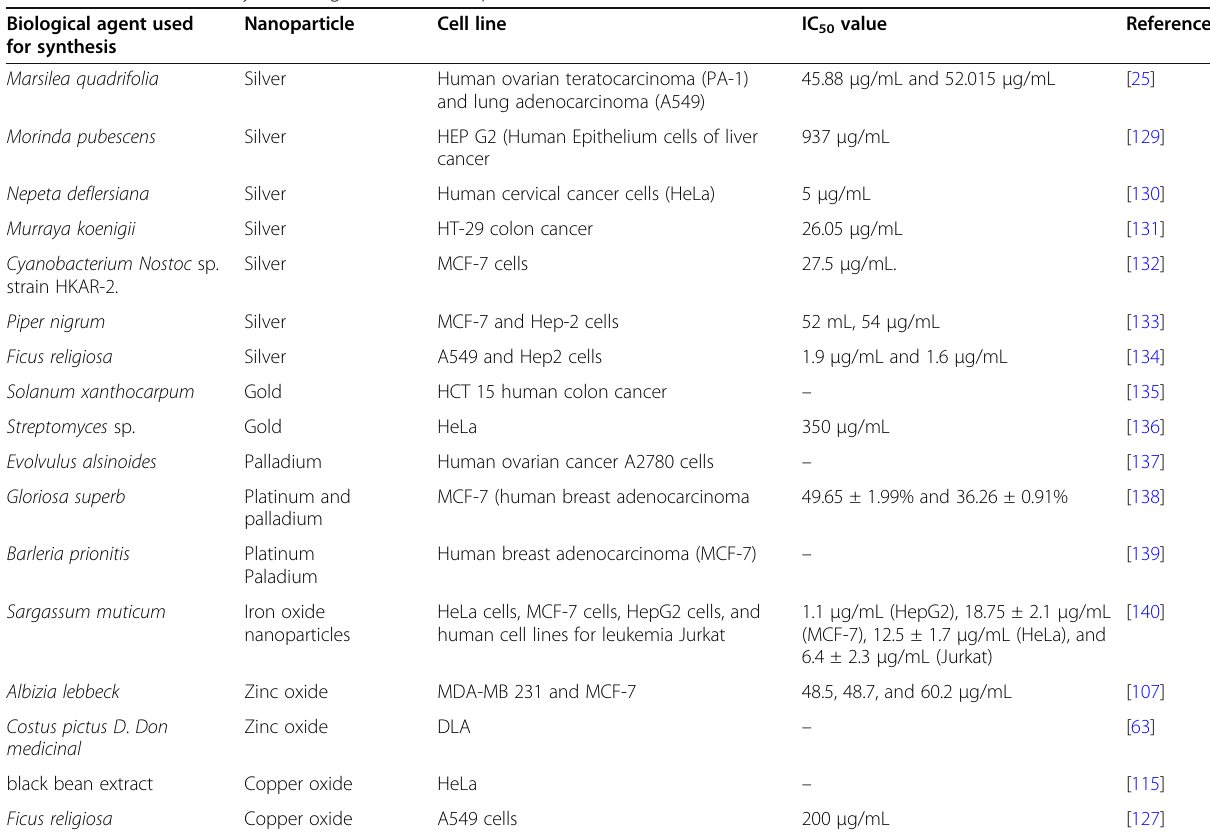
Table 5 Anticancer activity of biological metal nanoparticles Biological agent used for